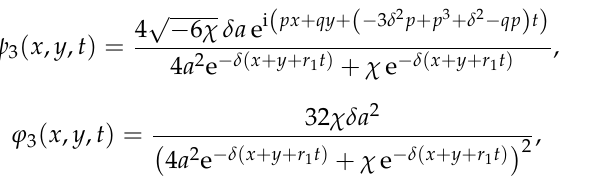
. The graph (Figure 2) of Equation (15) for various